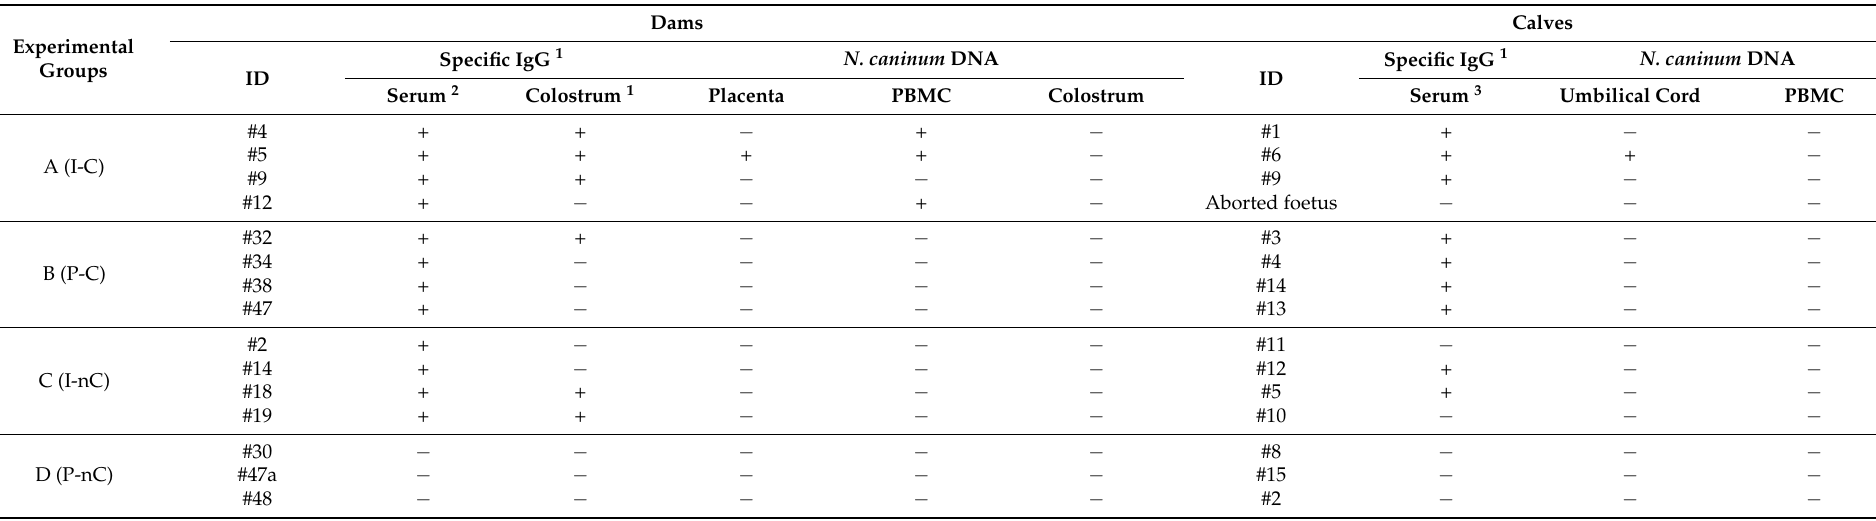
Table 3. N. caninum -serological status in dams and their offspring from different groups at delivery, before colostrum intake. I-C: inoculated and challenged; P-C: placebo and challenged; I-nC: inoculated not challenged; P-nC: placebo not challenged. PBMC: peripheral blood mononuclear cells. 1 Antibody detection by